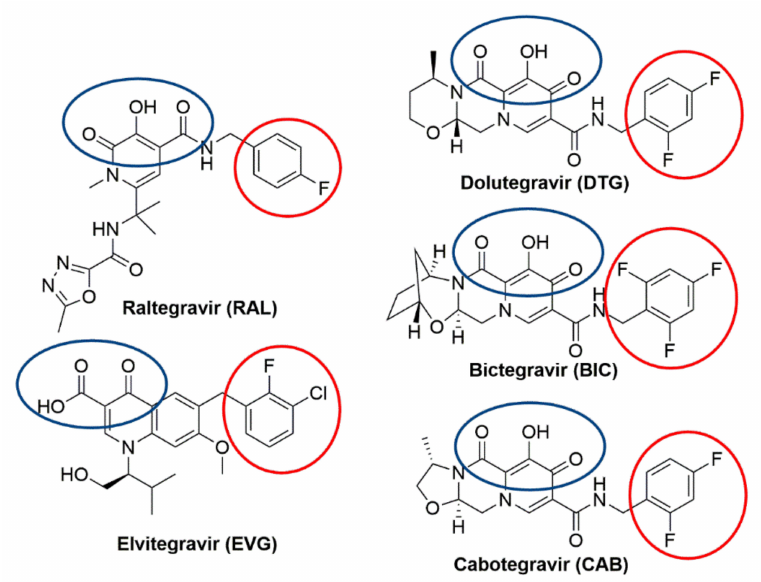
Figure 1. Chemical structures of the clinically relevant integrase strand transfer inhibitors (INSTIs). Chemical structures of the clinically relevant INSTIs are shown. The chelating motifs on the central- ized pharmacophores that interact with Mg 2+ cofactors in the integrase (IN) active site are highlighted with a blue circle. The halobenzyl moieties, which are connected to the centralized pharmacophore by a linker group, are circled in